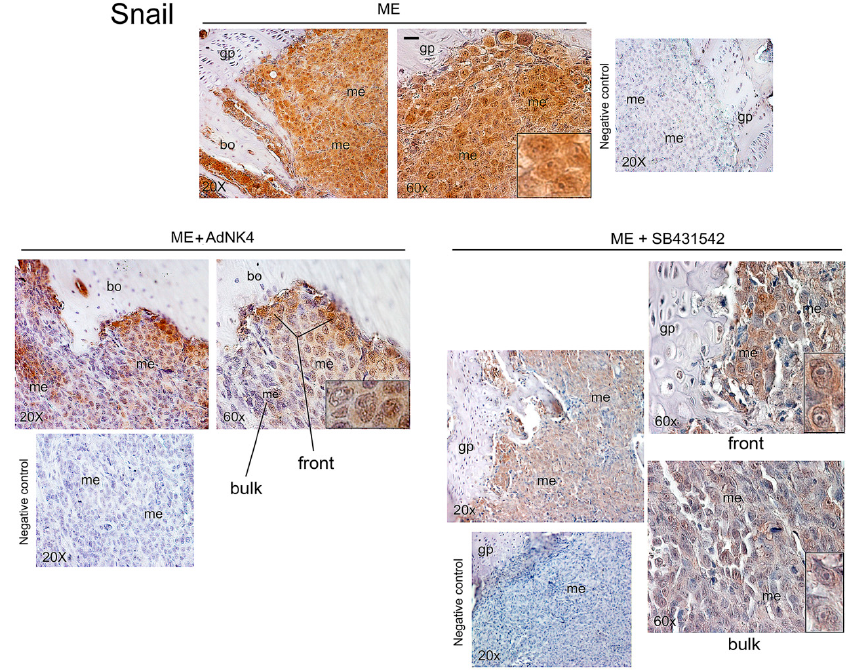
Figure 4. Effect of in vivo blockade of HGF or TGF β 1 signaling on Snail expression in bone metastasis of the xenograft mice. Three animals were sacrificed at 25 days for ME, and at 32 days for ME+AdNK4 and ME+SB431542, and we show representative images for Snail immunostaining using bone slides of mouse 1; magnifications of details are reported in the insets. gp, growth plate; me, metastasis; bo, bone. Negative controls were performed without the specific antibody. Scale bar = 120 μ m (reported in an exemplificative panel).